Question: Briefly state, in one sentence, what is plotted here.
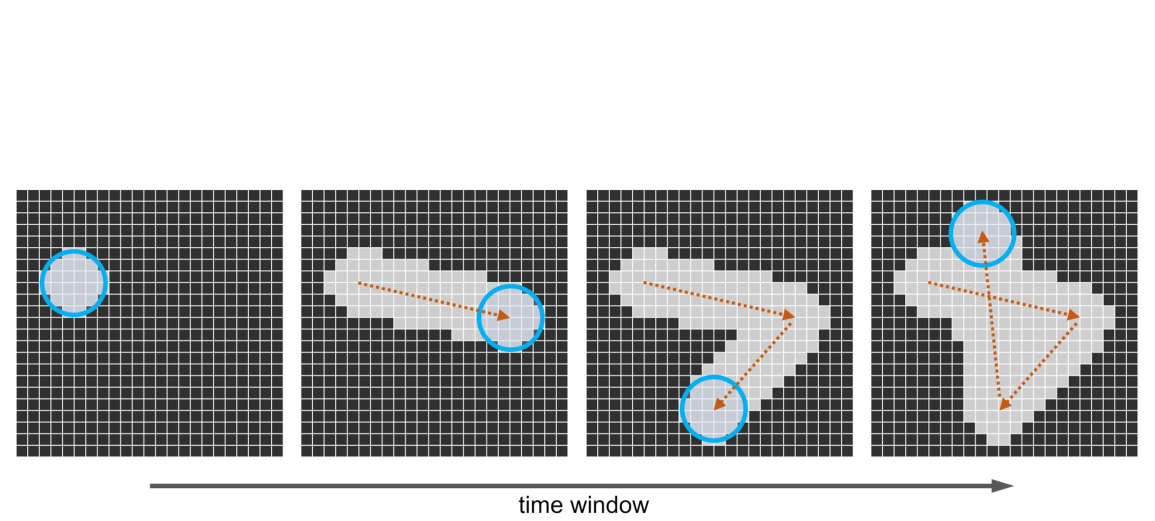
Answer: Visualization of the concept of the Dynamic Visual Field. The array of black pixels marks a large visual area that could potentially be observed by the participant. The blue circle marks the VF of the patient. Orange arrows indicate gaze movement over a specified time window. Light-grey pixels mark the area that has been observed at any point during the moving time window. The Dynamic Visual Field is defined as the ratio between light-grey pixels and total number of pixels at the end of the time window, meaning in the right-most image.